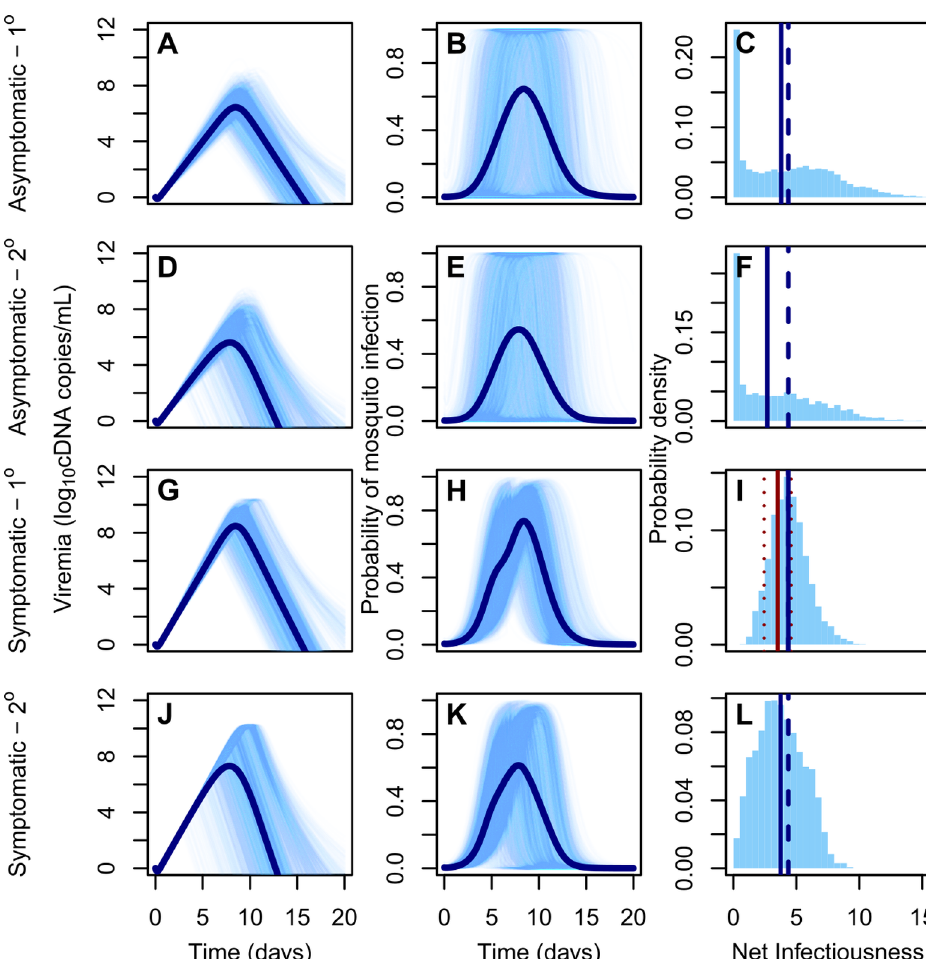
Fig 3. DENV viremia and infectiousness trajectories by infection class. (A,D,G,J): DENV viremia since time of infection for different infection classes and pre-exposure histories (1˚: primary infection; 2˚: secondary infection). Lighter lines denote 3,000 replicates and dark lines means. (B,E,H,K): Infectiousness of humans to mosquitoes over time. (C,F,I, L): Probability density of net infectiousness as defined in Eq (4)based on curves from the middle column. The solid blue line denotes the median and the dashed line denotes the median for the reference group (1˚ symptomatic). The solid and dashed red lines denote the mean and 95% confidence interval of the net infectiousness of 1˚ symptomatic infections as measured empirically